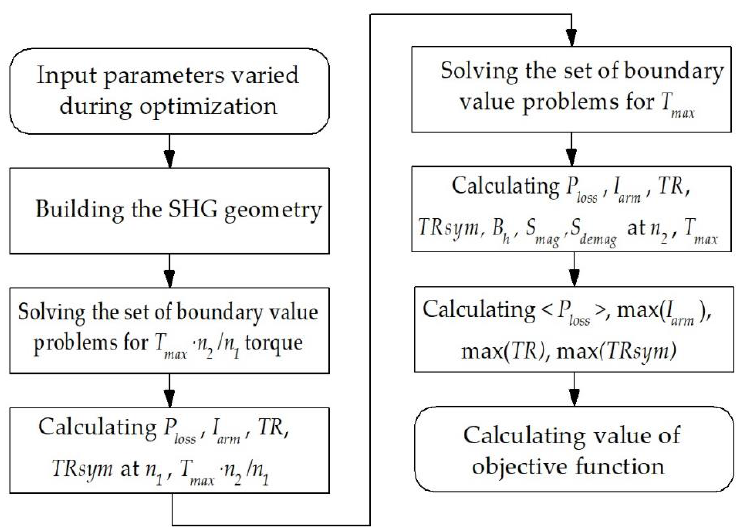
Figure 7. Order of the SHM performance calculation during one step of the optimization. The objective function is defined by Equation (6). The input parameters are shown in Table 2.